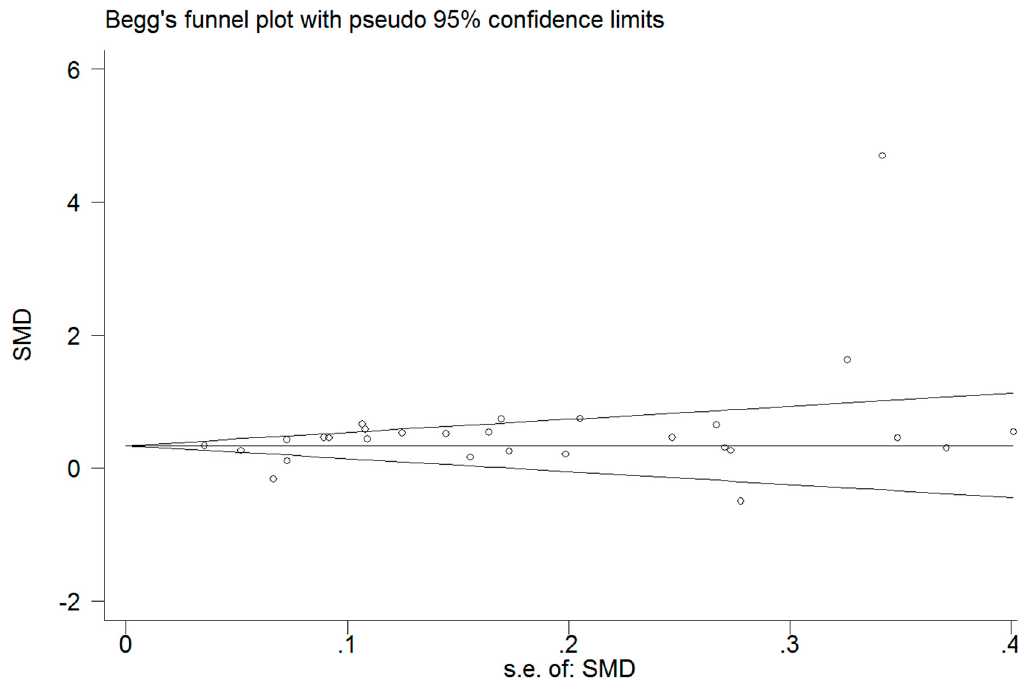
Figure 5. Funnel plot of CETP TaqIB polymorphism and HDL-C level ( B1B1 vs. B2B2 ). Each small circle represents a separate study for the indicated association.